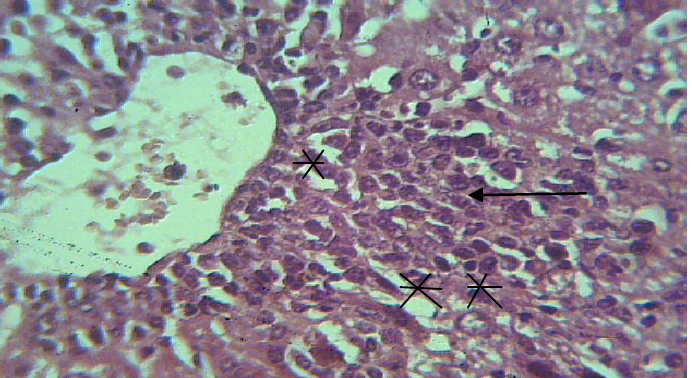
Fig 4: : Histological section of the mice liver at 2 weeks post immunization with HK-CA+FCA showed marked mononuclear cells aggregation arround the central vein( ) and in the liver parenchyma(*) as well as in the lumen of the central vein(**).H&E stain.